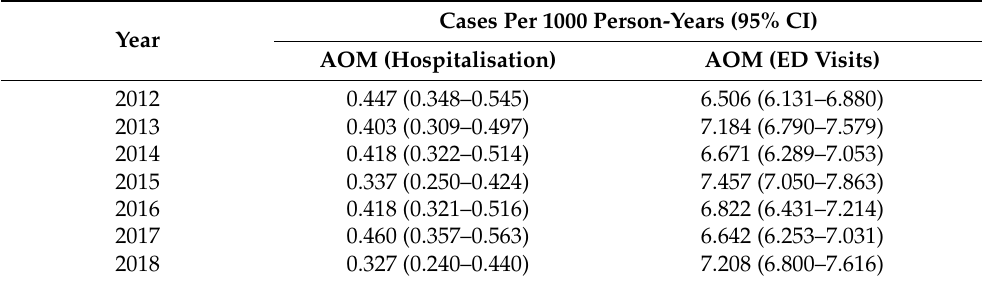
Table 4. Annual incidence of AOM hospitalisation and ED visits between 2012 and 2018, for children < 15 years of